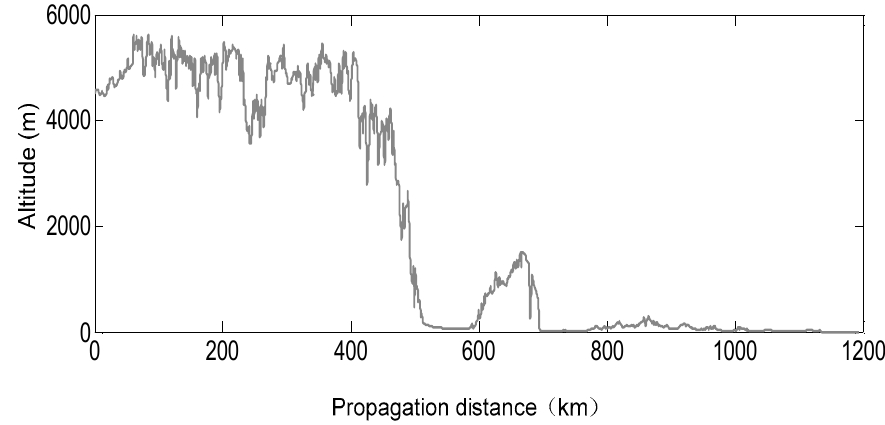
Figure 15. Landform profile of the Naqu region due south.